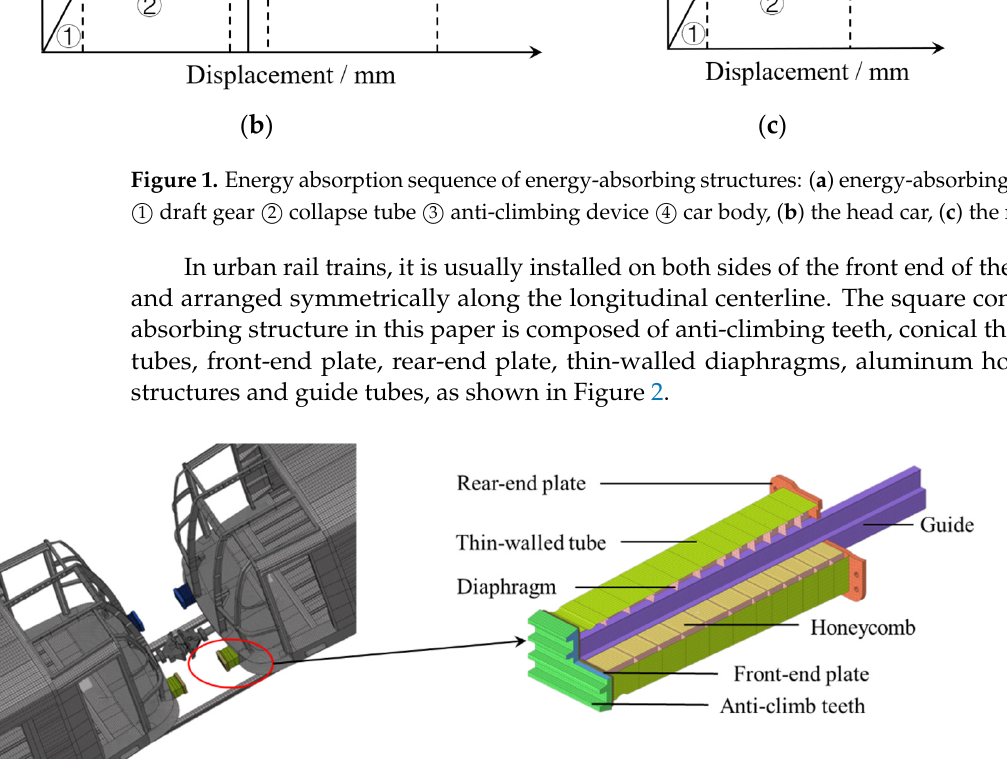
Figure 1. Energy absorption sequence of energy-absorbing structures: ( a ) energy-absorbing struc- tures: ① draft gear ② collapse tube ③ anti-climbing device ④ car body, ( b ) the head car, ( c ) the middle car.